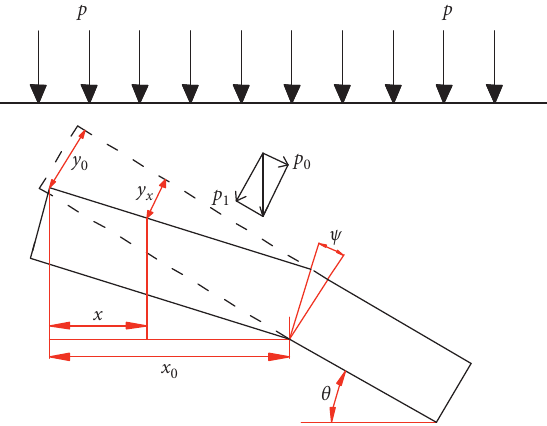
Figure 3: The basic roof fracture structure and stress condition above coal mass adjacent to